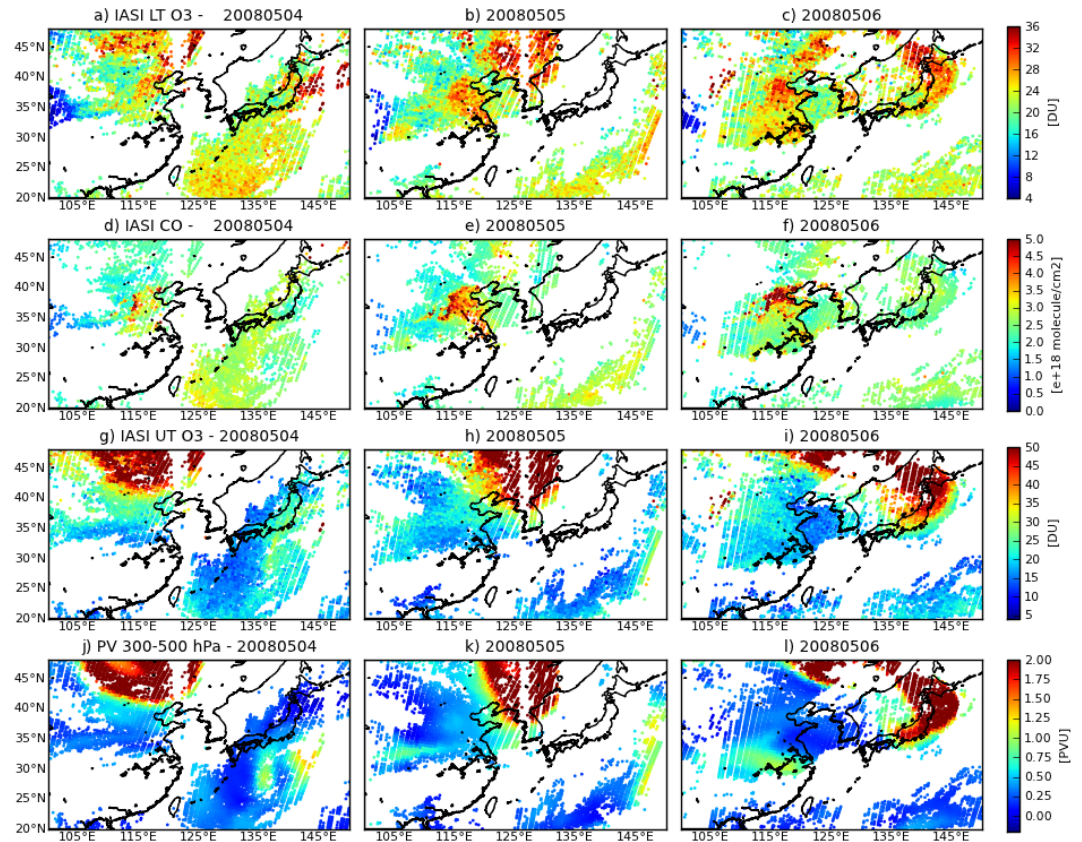
Figure 2. Panels (a–c) : lower-tropospheric ozone columns (surface to 6kma.s.l.) retrieved from IASI from 4 to 6 May 2008; panels (d–f) : total CO columns retrieved from IASI; panels (g–i) : upper-tropospheric ozone columns (6 to 12kma.s.l.) retrieved from IASI; panels (j–l) : potential vorticity (PV) from ERA5 Interim reanalysis averaged between 300 and 500hPa.